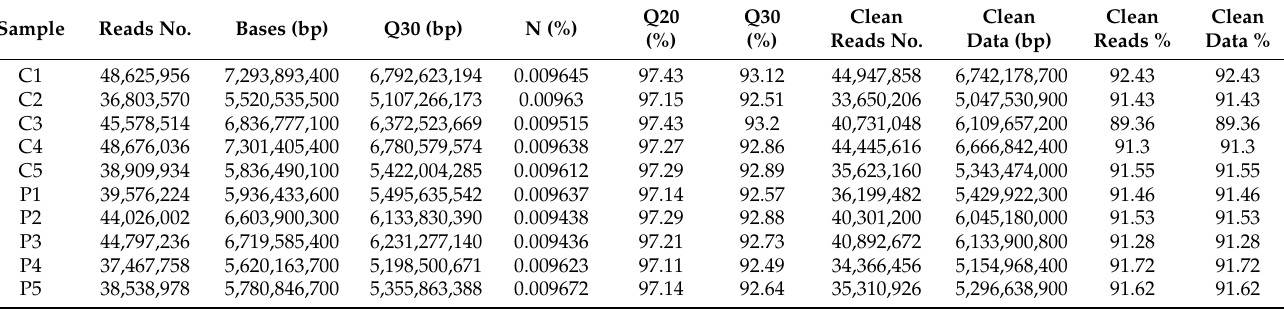
Table 1. Statistics for the sequenced transcriptome